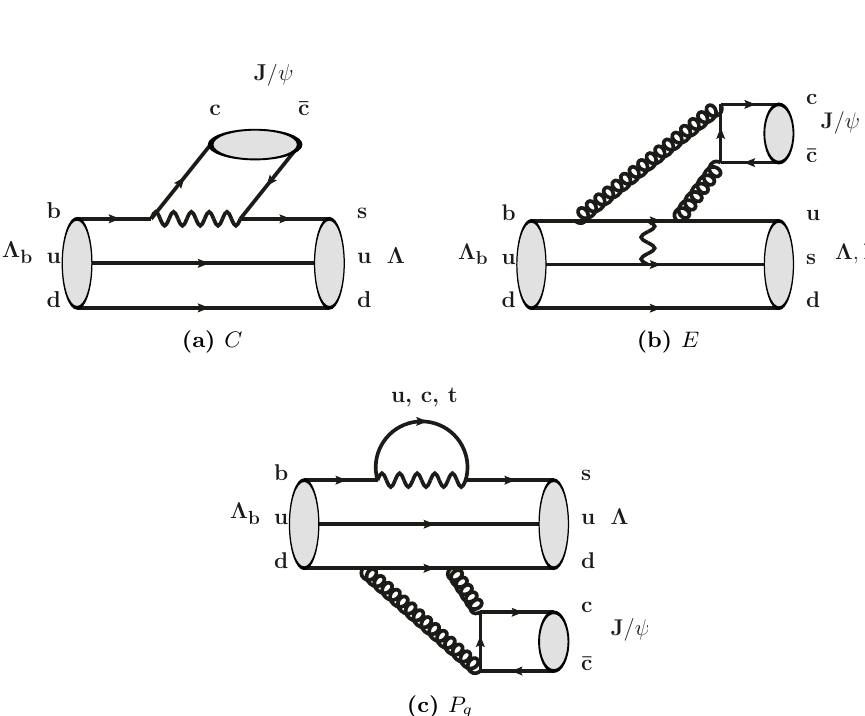
Figure 1. Topological diagrams for the decays (cid:3) b ! (cid:3) J= and (cid:3) b ! (cid:6) J= . Note that in the exchange diagram one gluon alone can not create the J= because it is a color singlet.